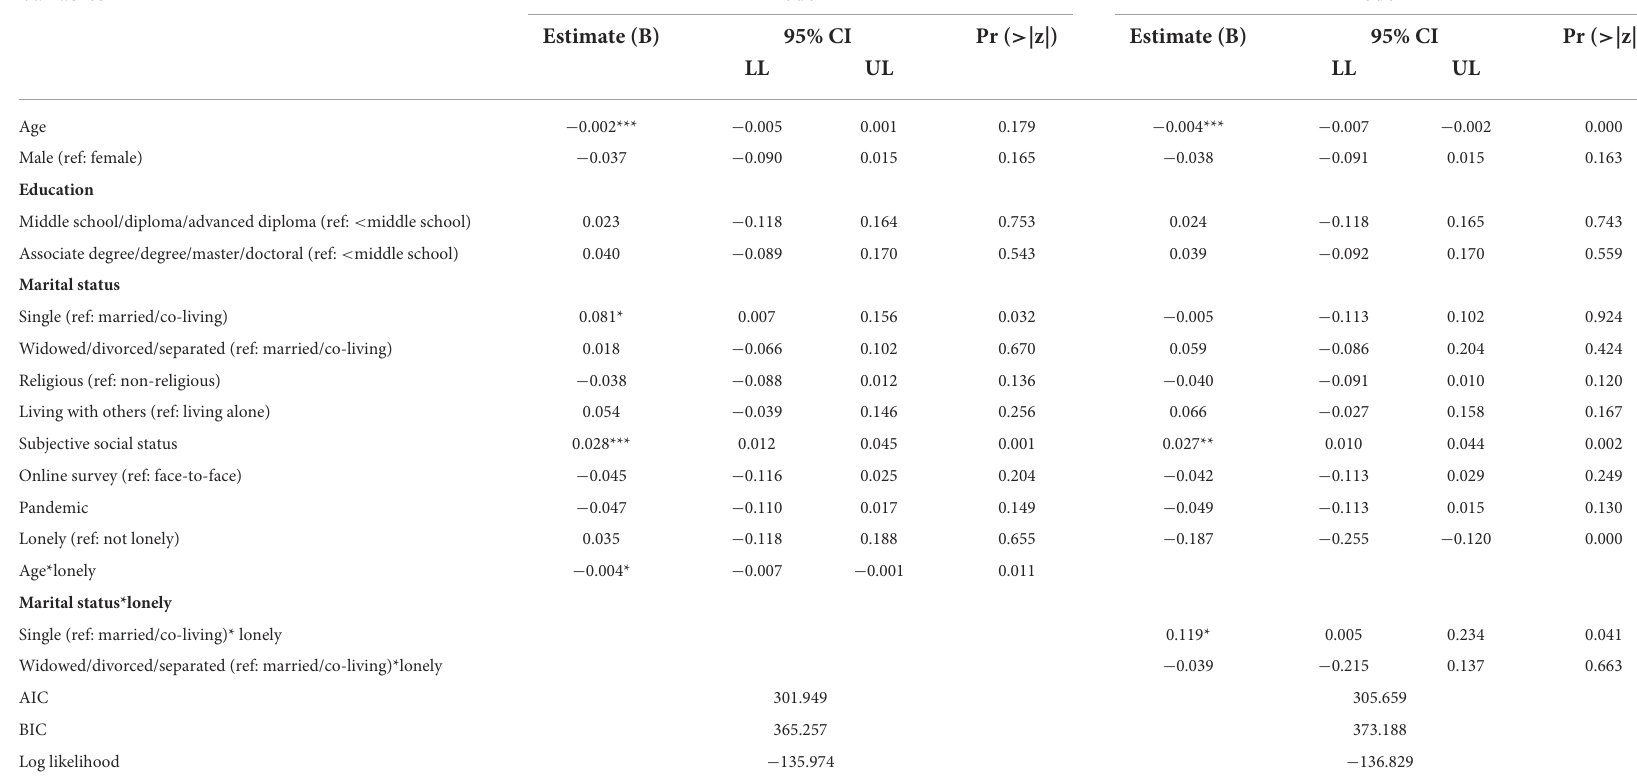
TABLE 3 Tobit regression analyses of factors associated with EQ-5D-5L HK index scores with interaction terms. Variables Model 1 Model